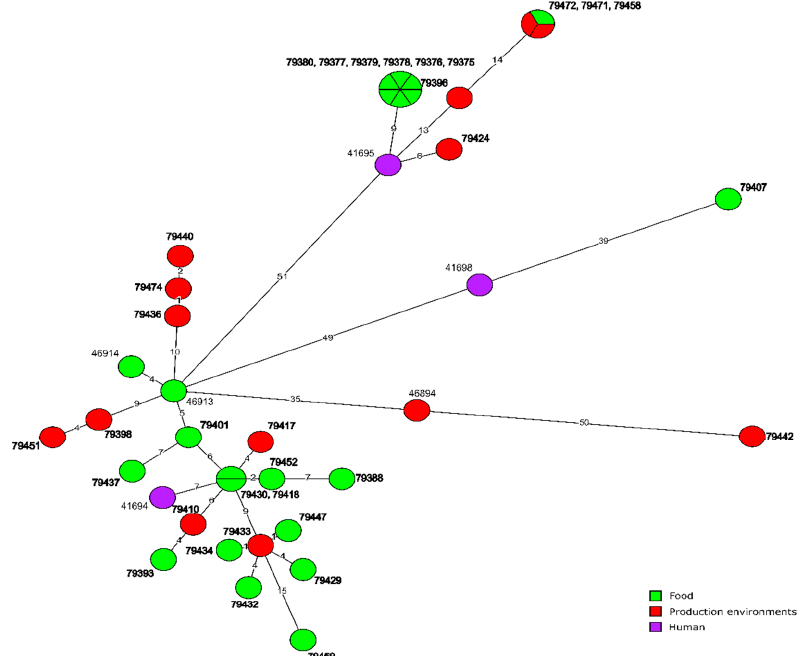
Figure 4. Minimum spanning tree (MST) based on the cgMLST profiles of L. monocytogenes CC155 tested in the present study with publicly available six strains of CC155 from Poland. The Source of the isolates are represented by colored circles where the size is proportional to the number of strains. Numbers on the branches show alleles differences between neighboring nodes (CTs). The strain numbers in bold represent L. monocytogenes isolates from the present study.